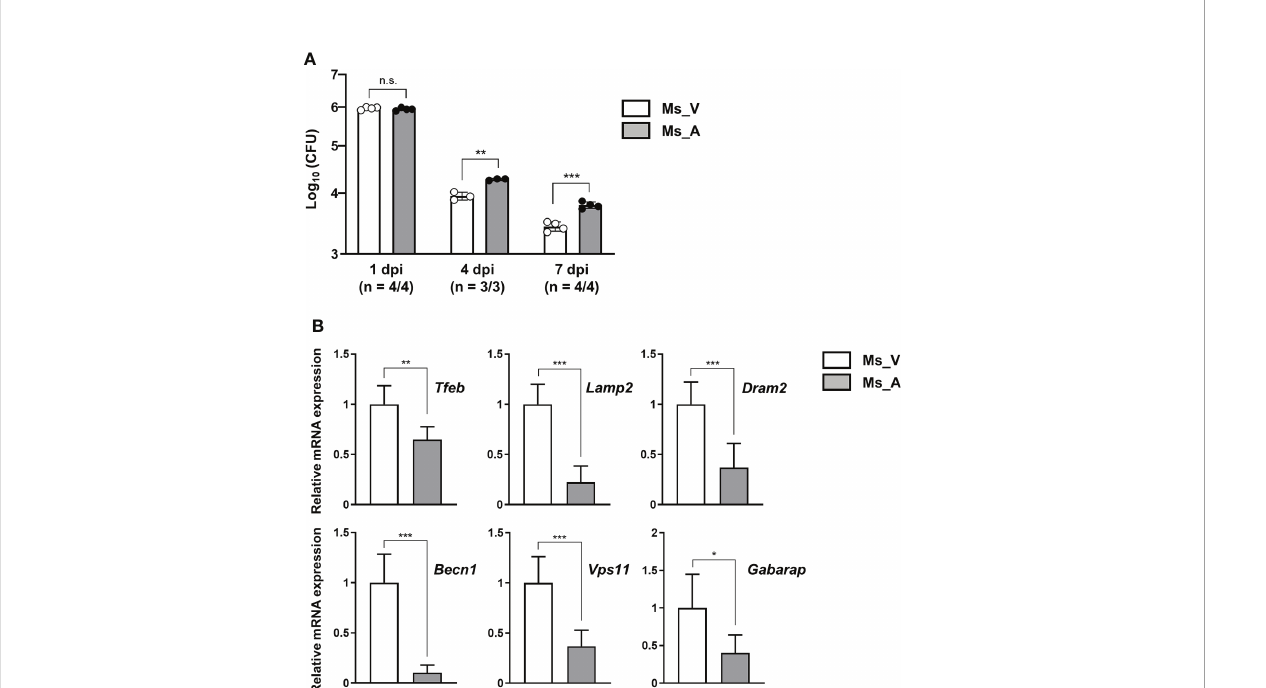
FIGURE 7 AcpM overexpression increases the survival of M. smegmatis in-vivo . (A) C3HeB/FeJ mice (n = 22) were intranasally infected with recombinant M. smegmatis strains Ms_AcpM (n = 11) or Ms_Vec (n = 11) and euthanized at the indicated times after infection (1, 4, or 7 dpi). The lungs were resected from mice to assess the bacterial burden by CFU assay. (B) Lung lysates from two randomly selected mice from each group were analyzed in triplicate using qRT-PCR to evaluate the expression level of autophagic/lysosomal genes at 7 dpi. Statistical signi fi cances were calculated with an unpaired t -test. Data are presented as mean ± SD. * P < 0.05; ** P < 0.01; *** P < 0.001; a.u., arbitrary unit; n.s., not signi fi cant; CFU, colony-forming unit; dpi, days post-infection; Ms_V, Ms_Vec-infected; Ms_A,